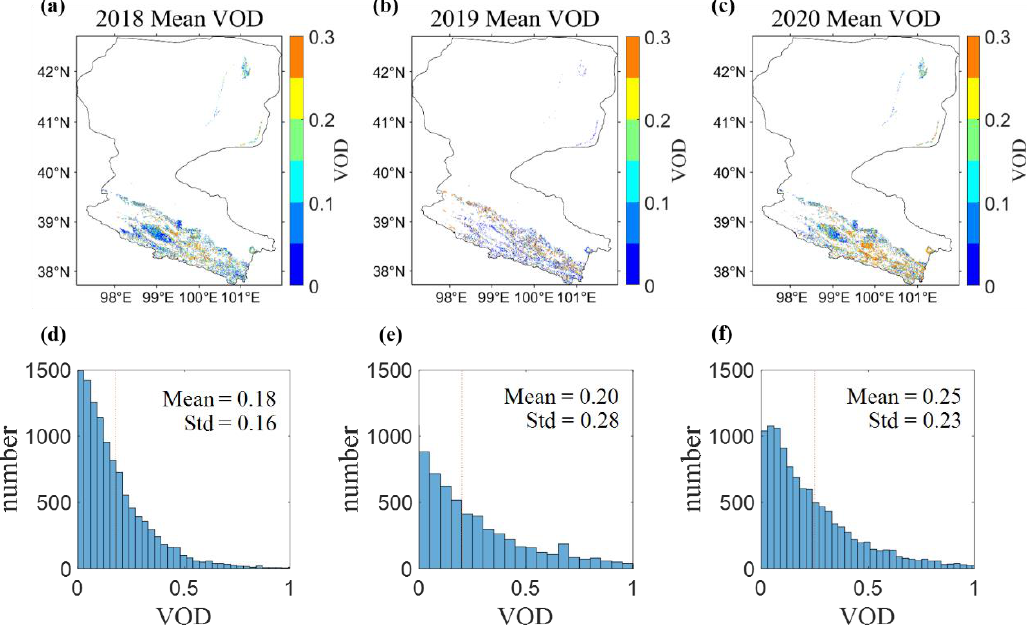
Figure 7. The upper panel represents the spatial patterns of the annual average of VOD. From left to right: ( a ) 2018, ( b ) 2019, ( c ) 2020. The bottom panel represents the histograms of the annual average of VOD. The red vertical line represents the mean value of VOD for each year. From left to right: